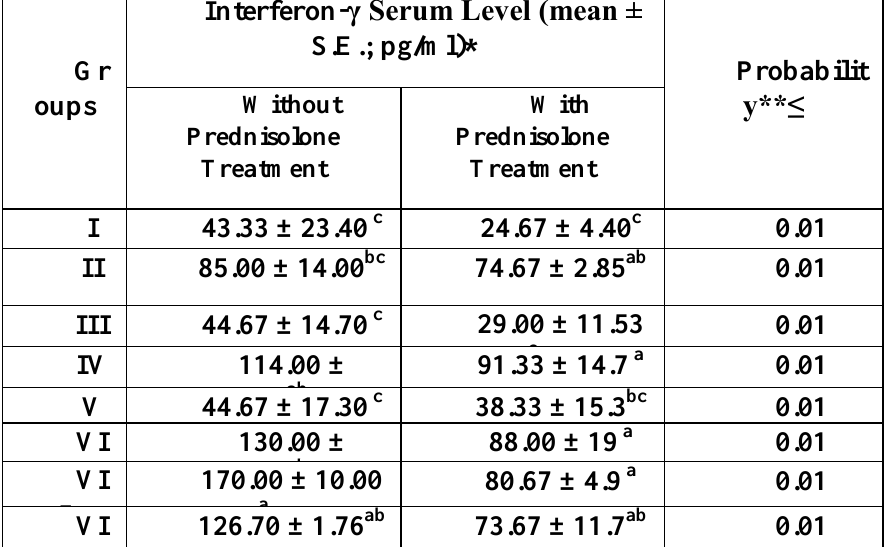
*Different letters: Significant difference (P≤0.05) between means of the same Colum **The comparison is between means of the two columns (horizontal